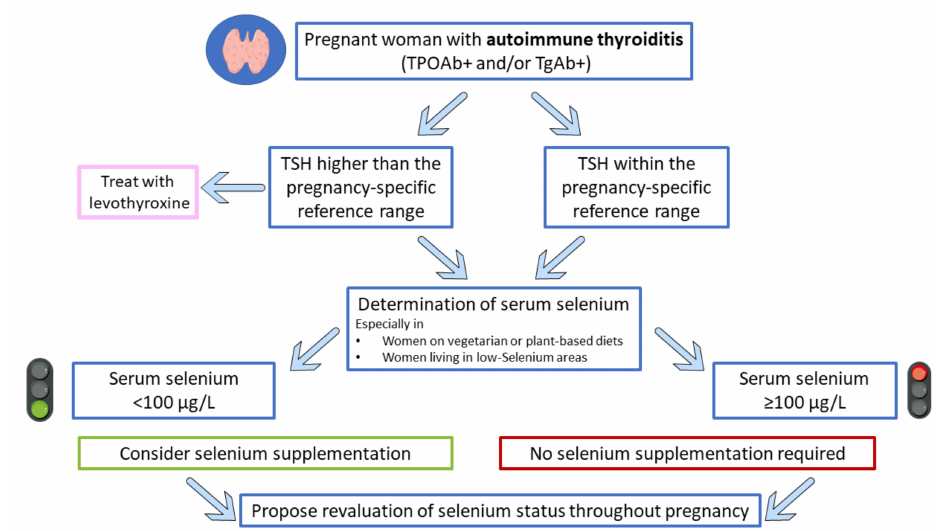
Figure 2. Proposed algorithm for selenium supplementation in pregnant women with thyroiditis. This figure was created using Servier Medical Art templates, which is licensed under the Creative Com- mons Attribution 3.0 Unported License; https://smart.servier.com (accessed on 17 February 2022).